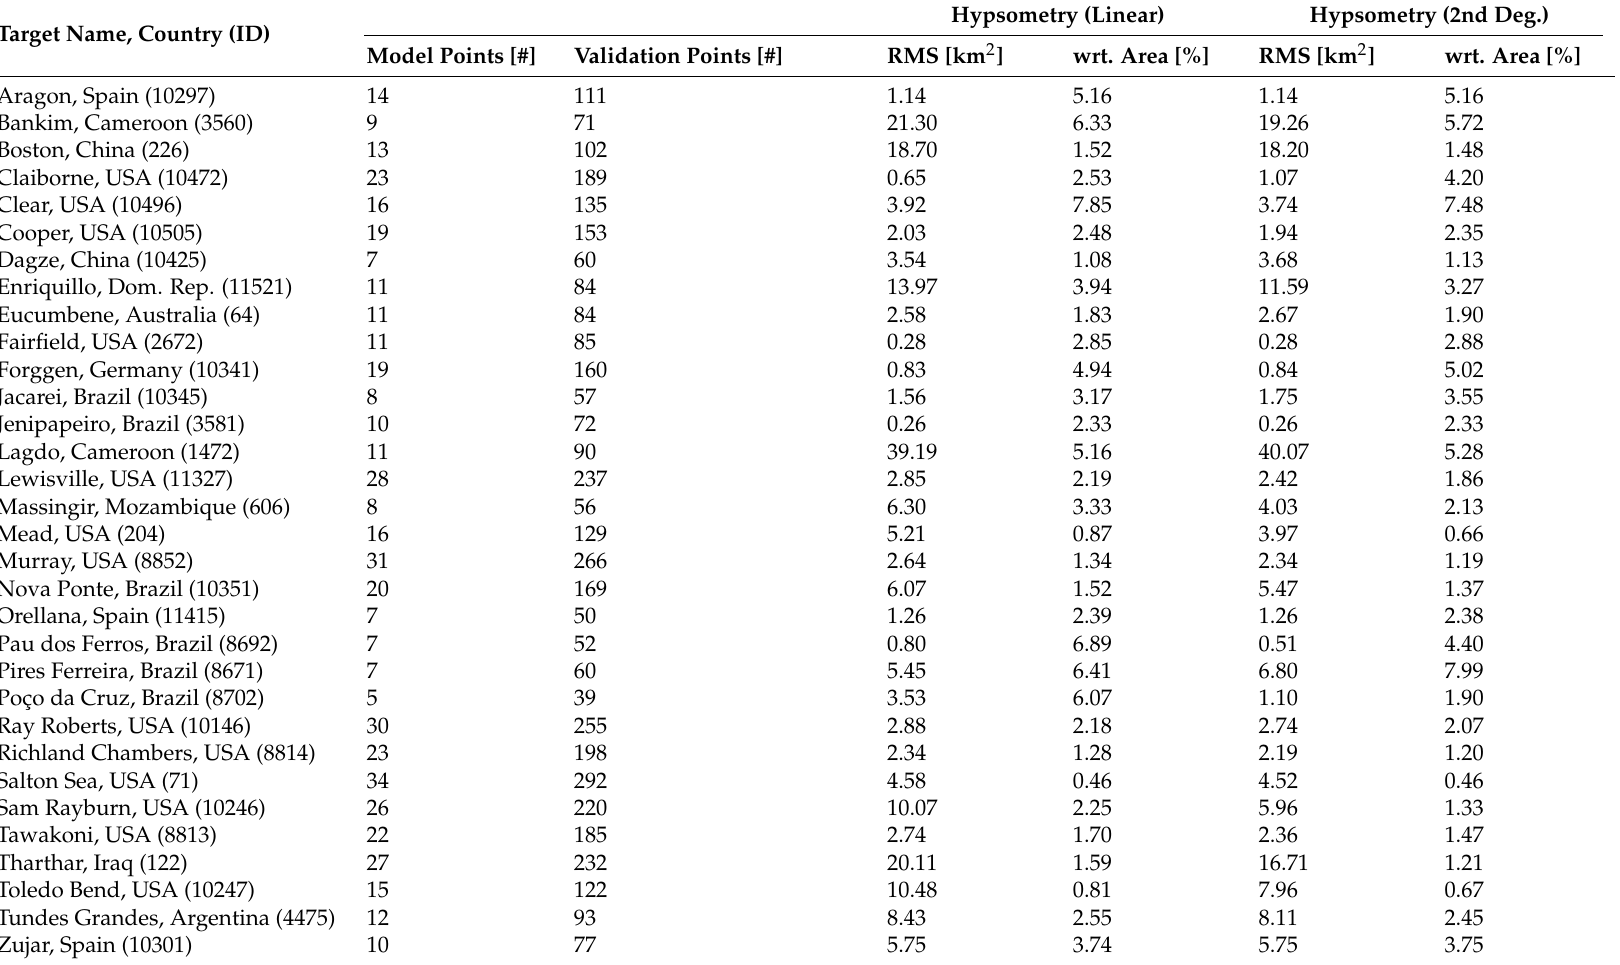
Table 6. Results of the cross-validation of 32 selected study areas. For each study area, the used number of points for the calculation of the hypsometry and the number of points for the validation are shown. Furthermore, the resulting RMS and relative RMS with respect to the maximum surface area using a linear and polynom of degree 2 are